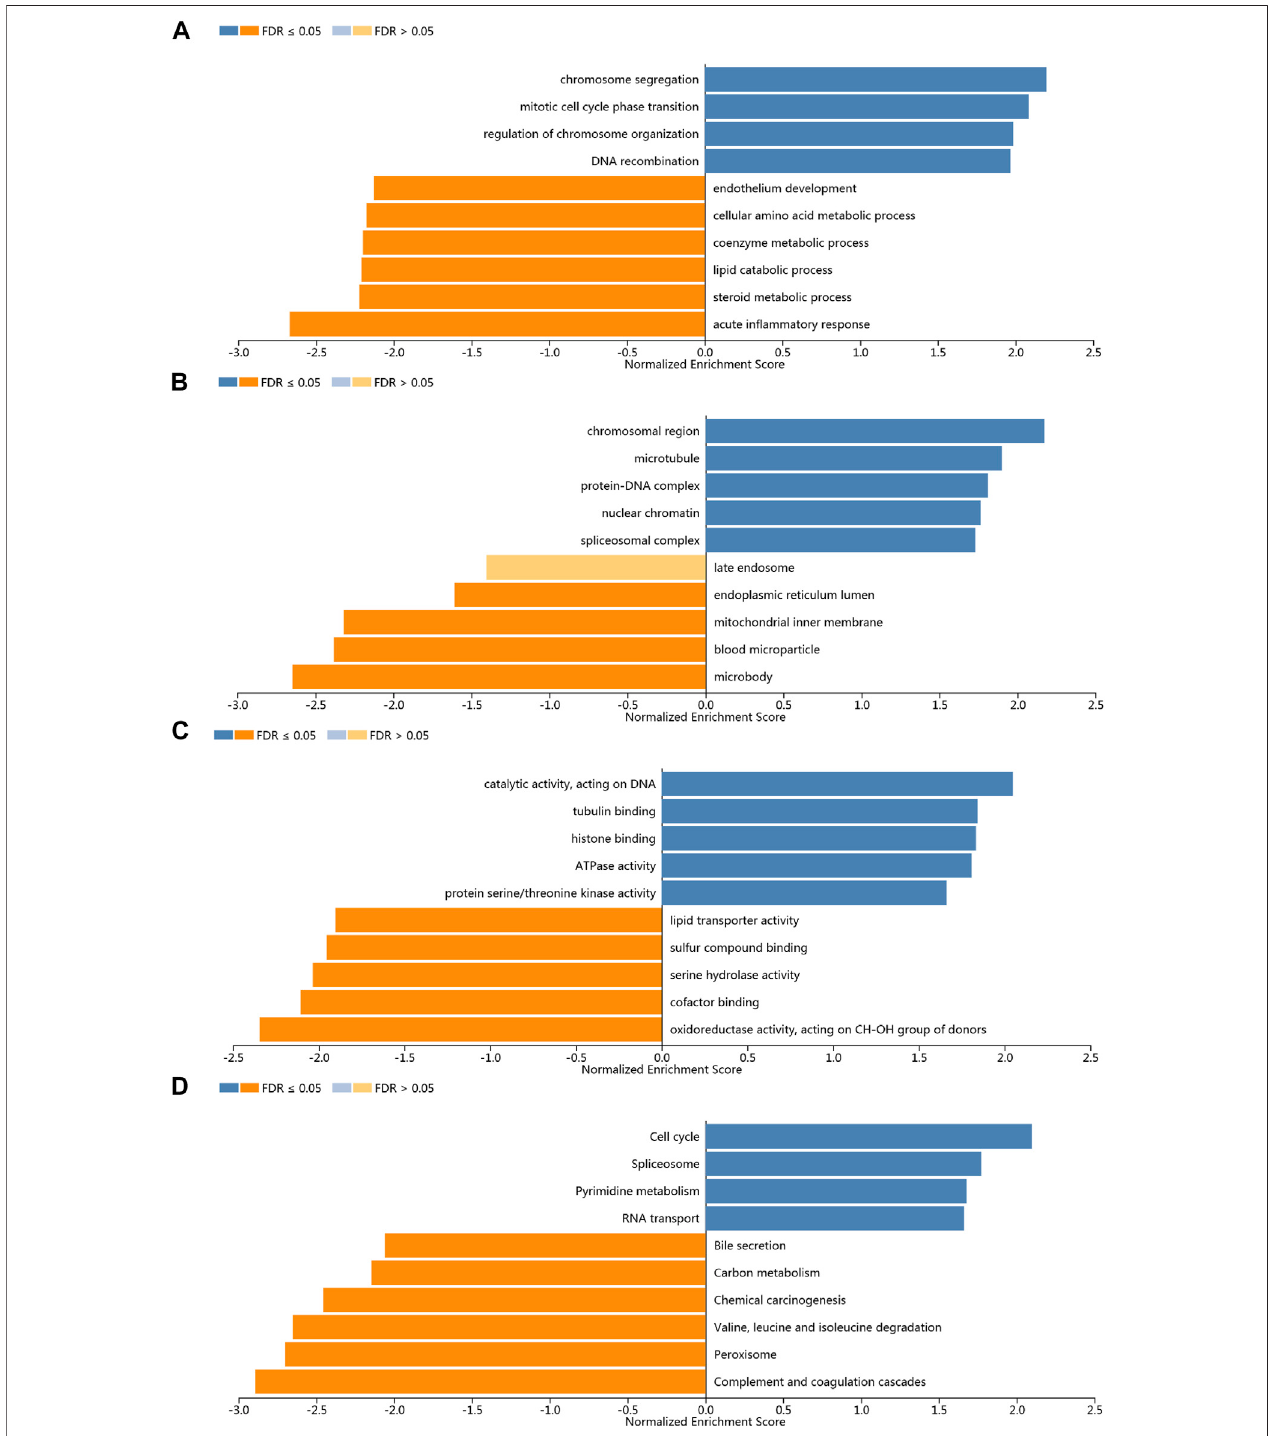
FIGURE 8 | Enrichment analysis of the genes altered in the KIFC1 neighborhood in LIHC. (A) Biological processes. (B) Cellular components. (C) Molecular functions. (D) KEGG pathway analysis.